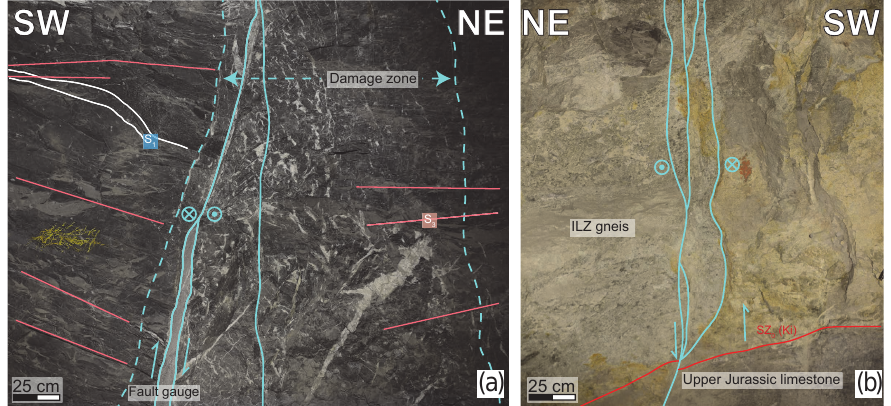
Figure A2. Youngest fault structures (F2) cross-cutting all previous structures in the sedimentary cover (a) and the basement (b) with an oblique to strike-slip